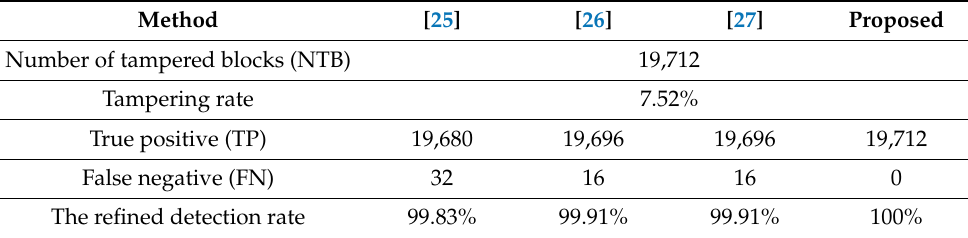
Table 4. Detectability comparisons using different